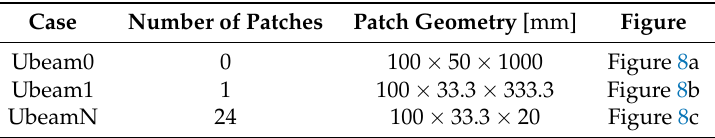
Table 1. Test cases and geometry for the U-forming beam structure. The geometry is given